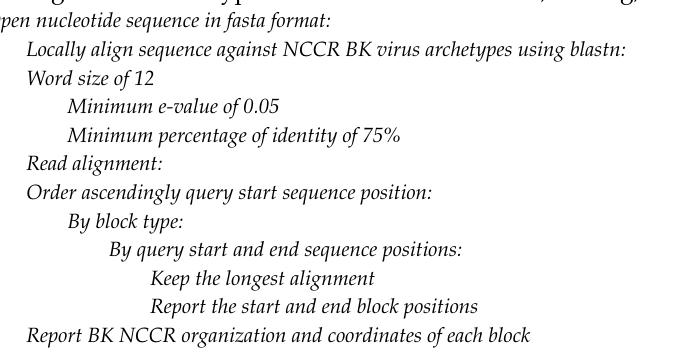
Algorithm of BKTyper for NCCR identification, scoring, and classification: Open nucleotide sequence in fasta